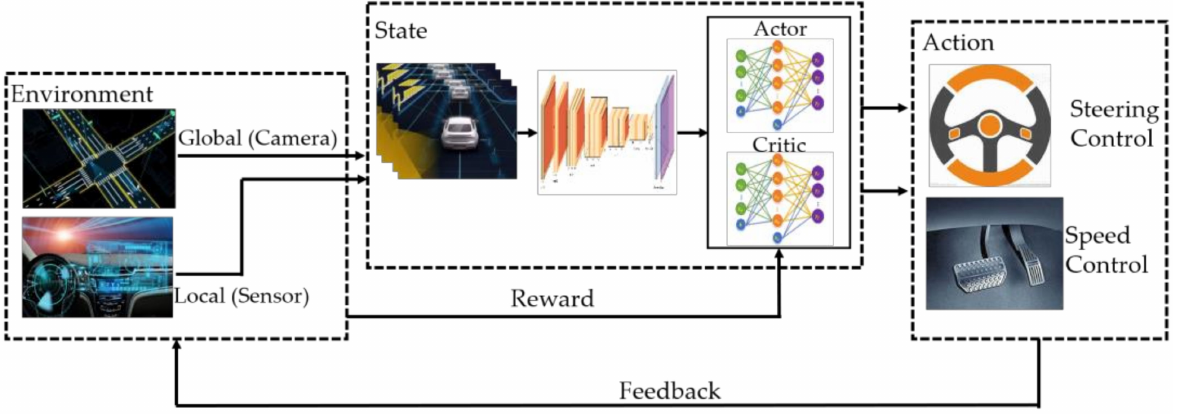
Figure 2. Deep reinforcement learning frame